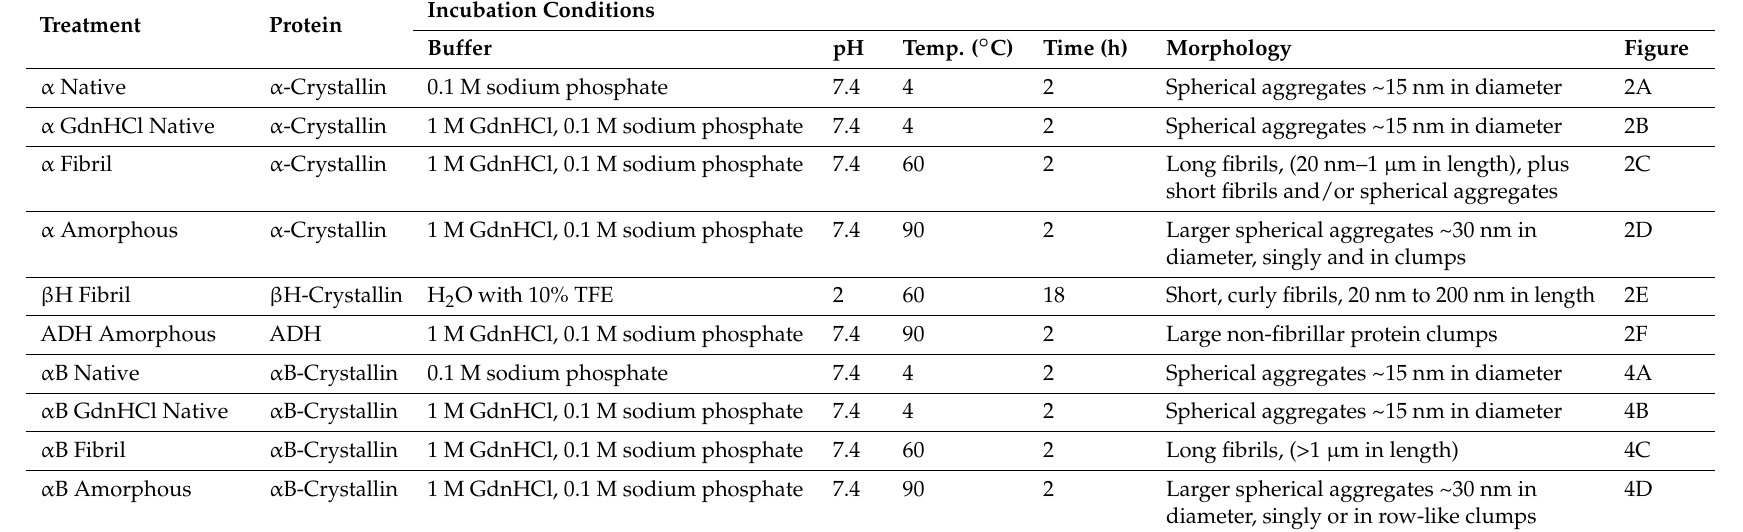
Table 1. α - and α B-crystallin species formed for chaperone assessment of structural